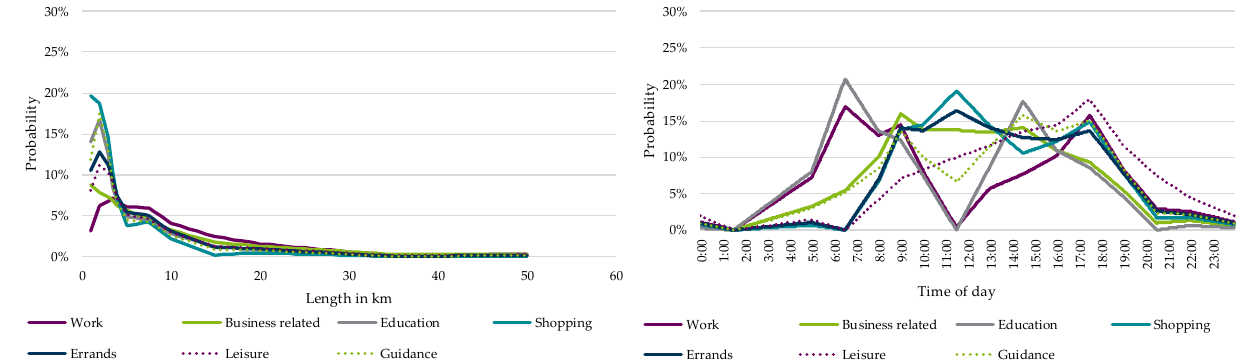
Figure 3. Left : Probability distribution of the length of the routes per vehicle according to the purpose of the route. Right : Probability distribution of the time of departure of a vehicle according to the purpose of the route based on data published in [27] for “Urban Region: Metropolis”.